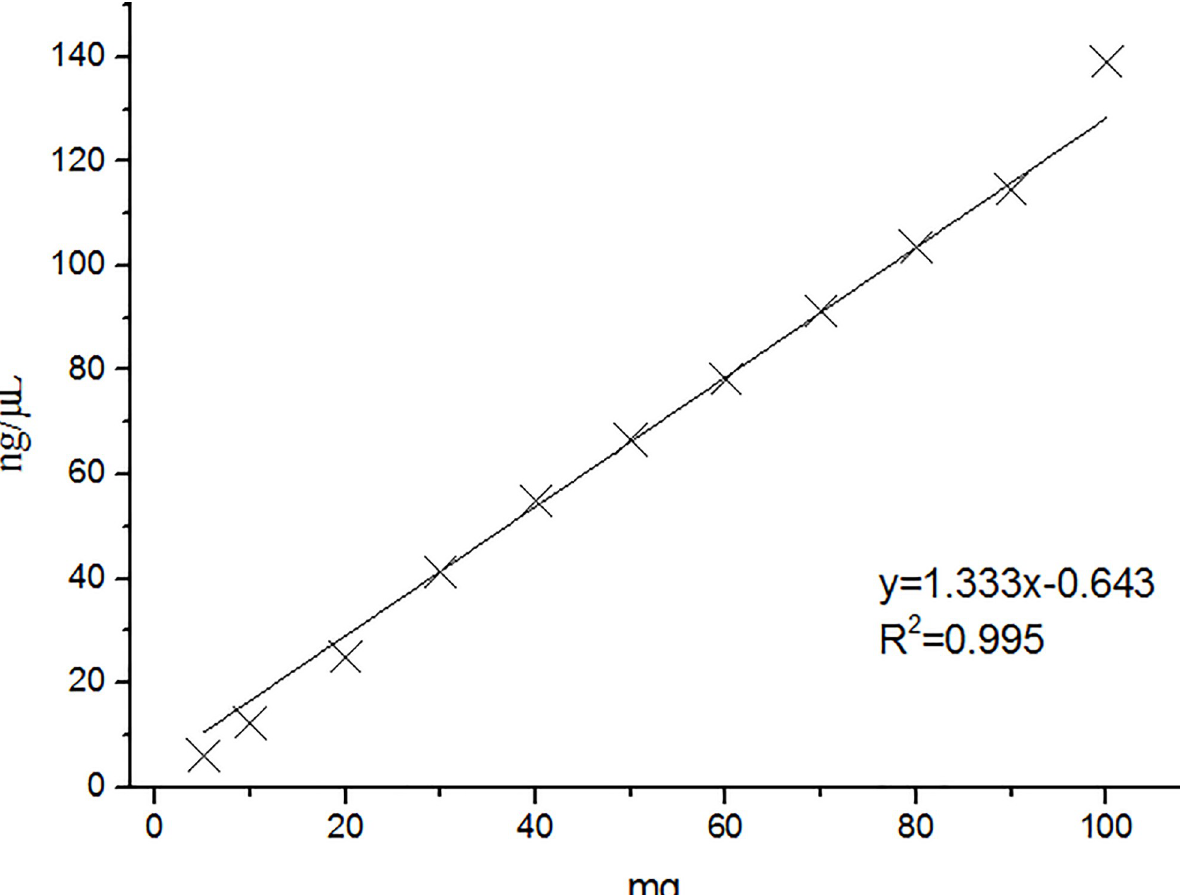
Fig 2. Correlation between tapioca dry weight and extracted